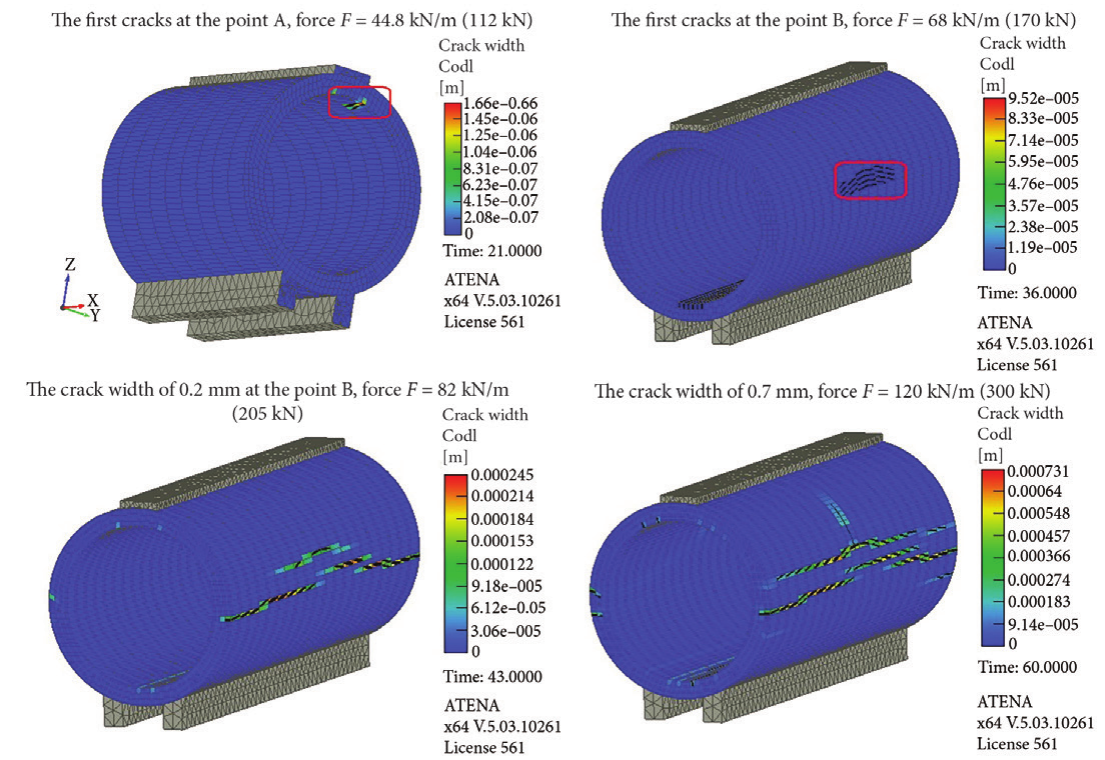
Fig. 9. Development of cracks and deformation depending on the applied